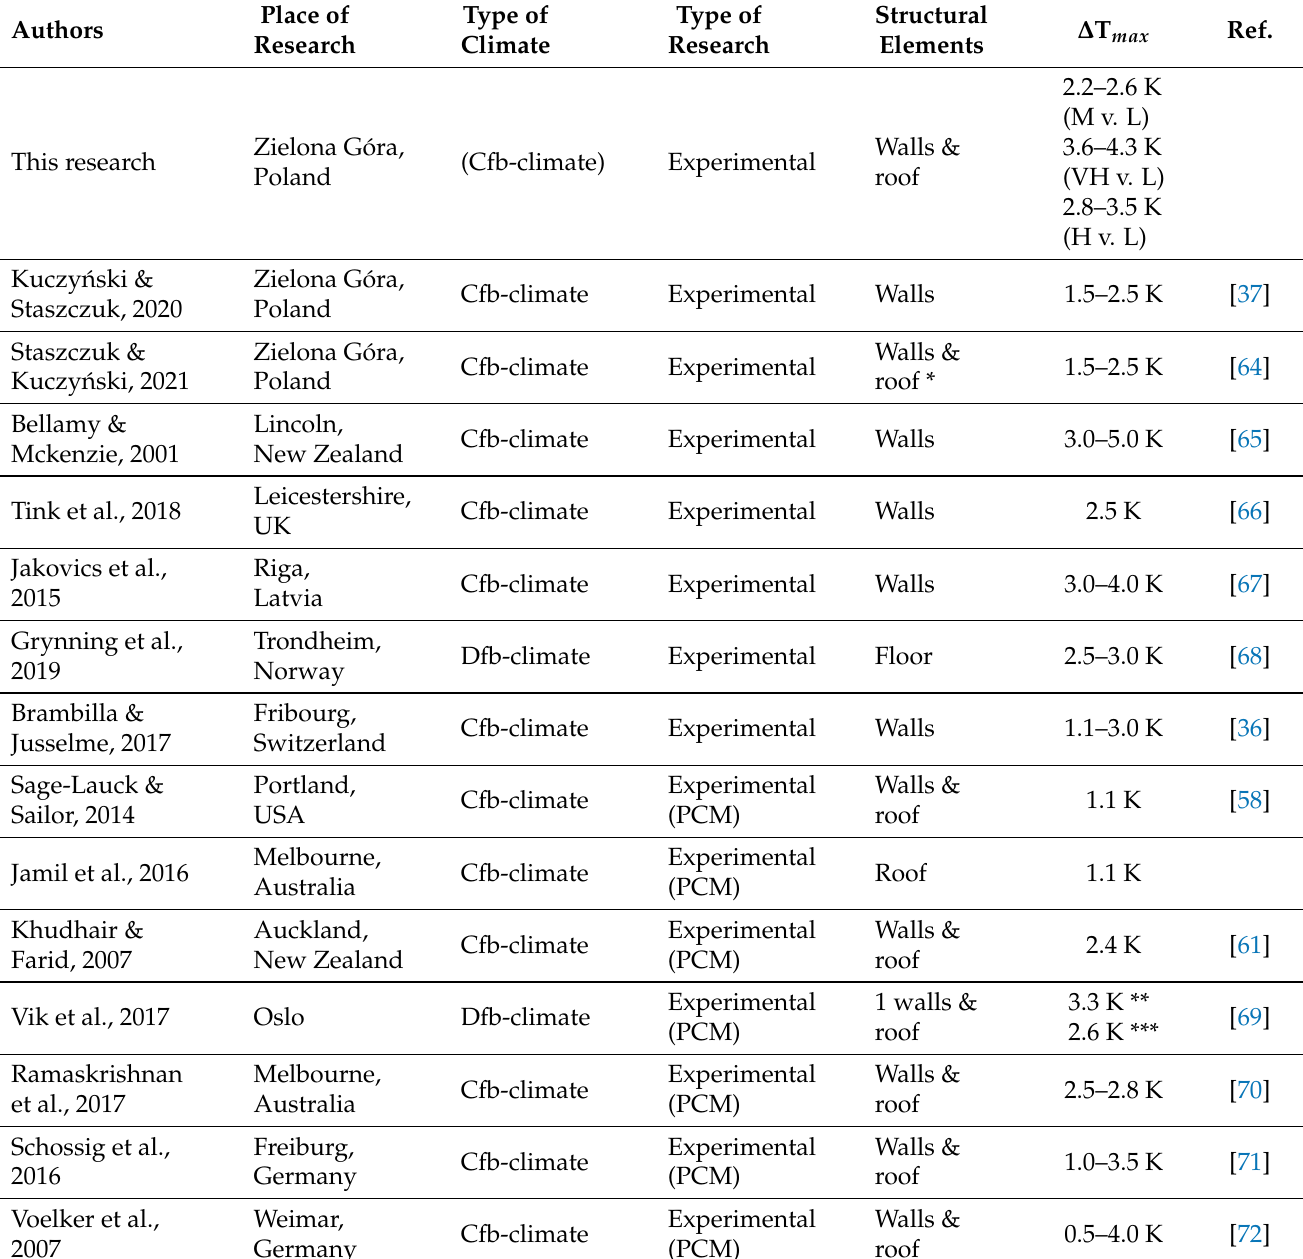
Table 3. Effects of reduced indoor temperature due to increased thermal mass in other experimental results conducted in the last two decades in a temperate and cold